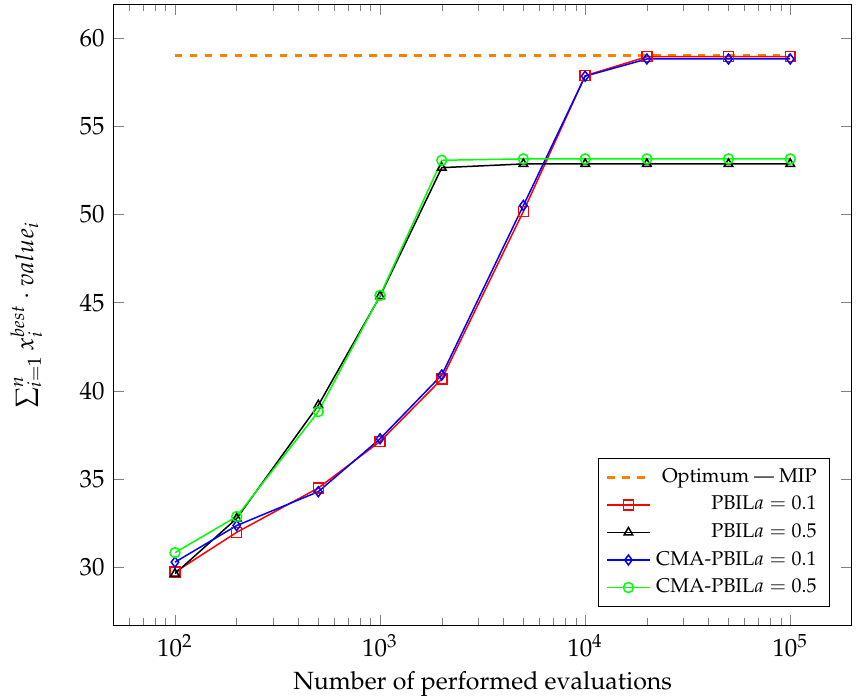
Figure 3. The average of the maximal values of the objective function calculated so far, test case no